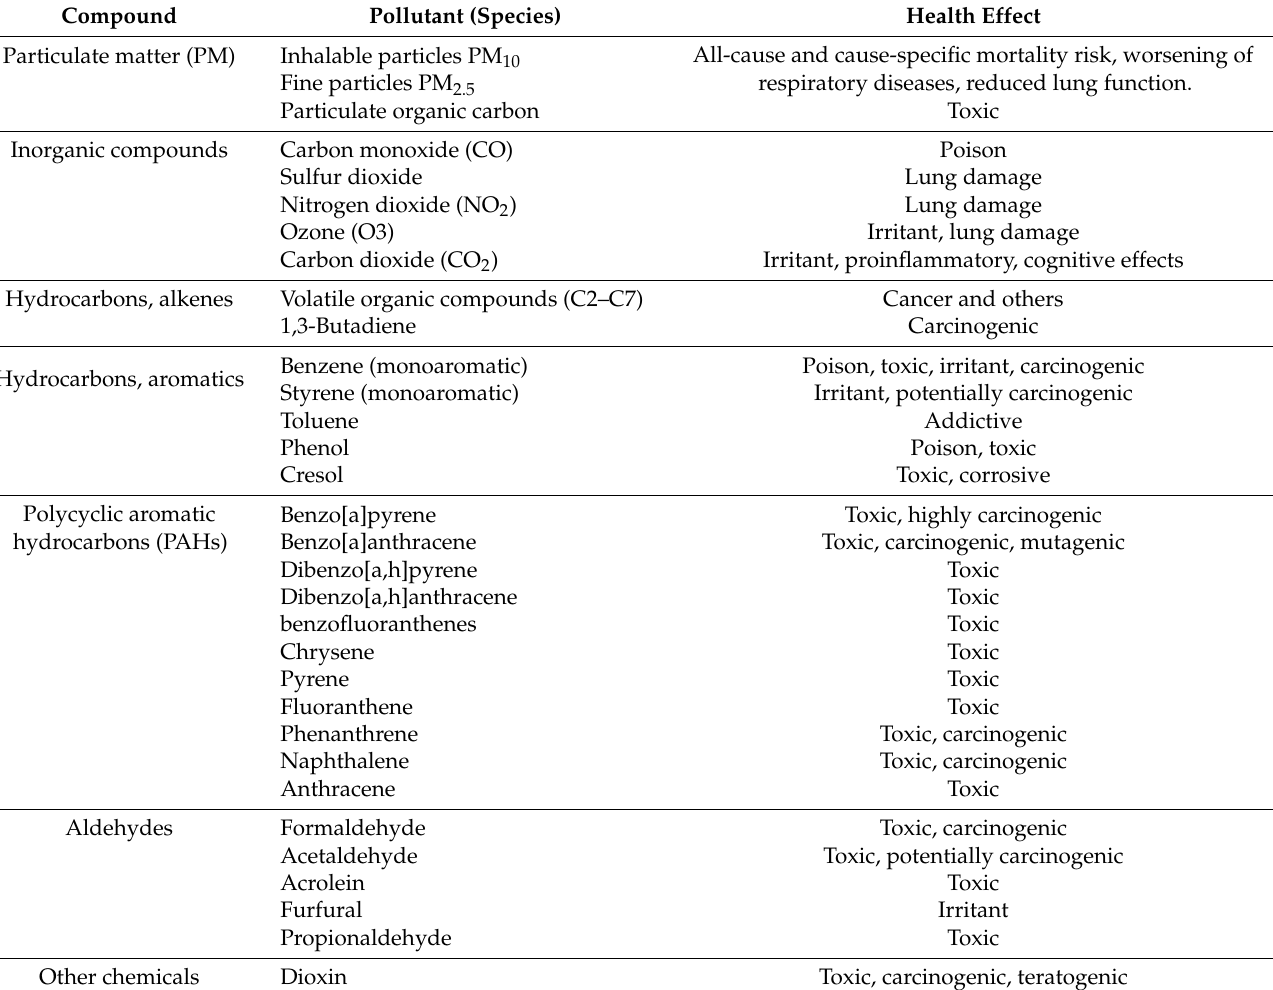
Table 1. Health-hazardous chemicals and particulate matter present in wood